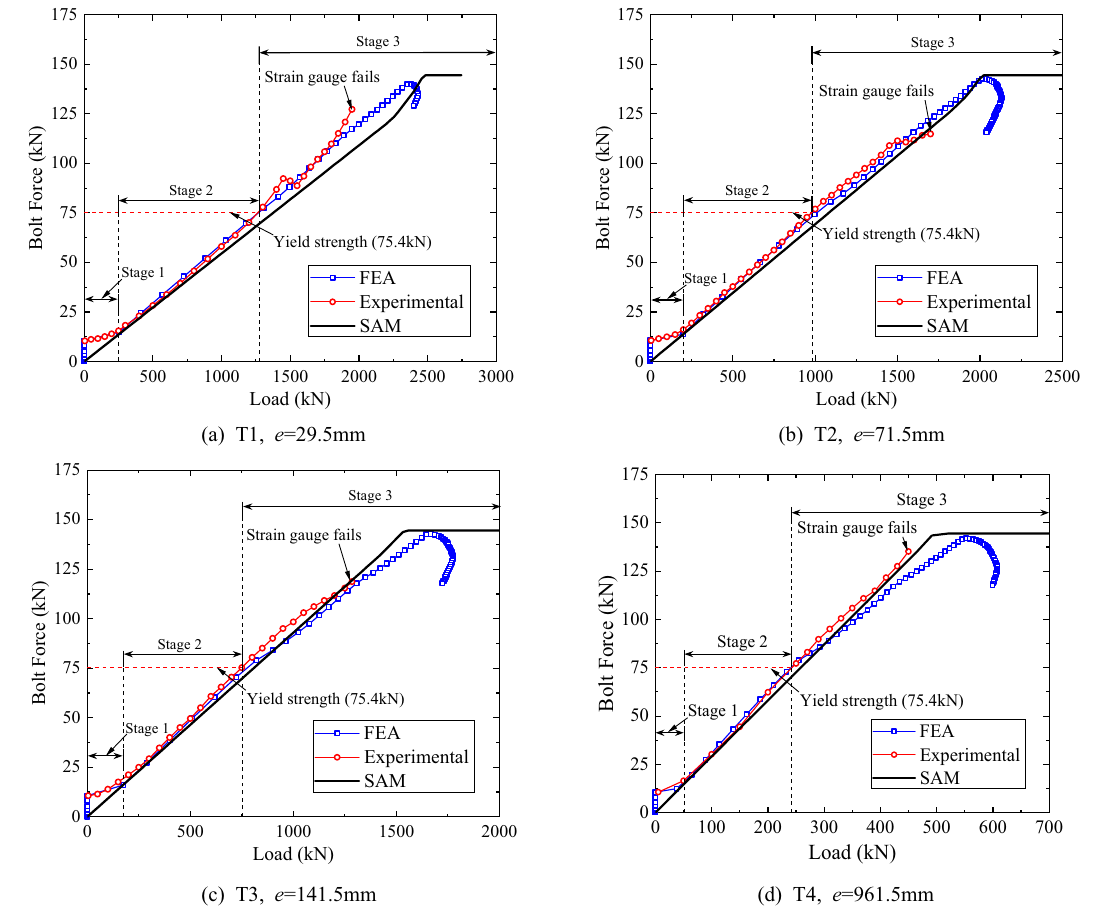
Figure 12. Internal tension forces of the farthest bolt (SBO-1).